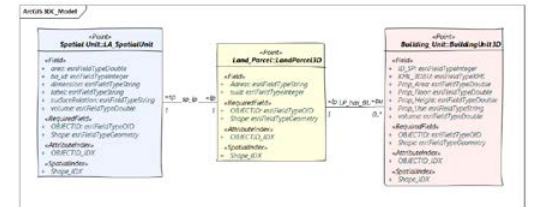
Figure 2. Conceptual schema defining the relationship between the classes: LA_SpatialUnit, LandParcel3D and BuildingUnit3D (Gkeli et al.,